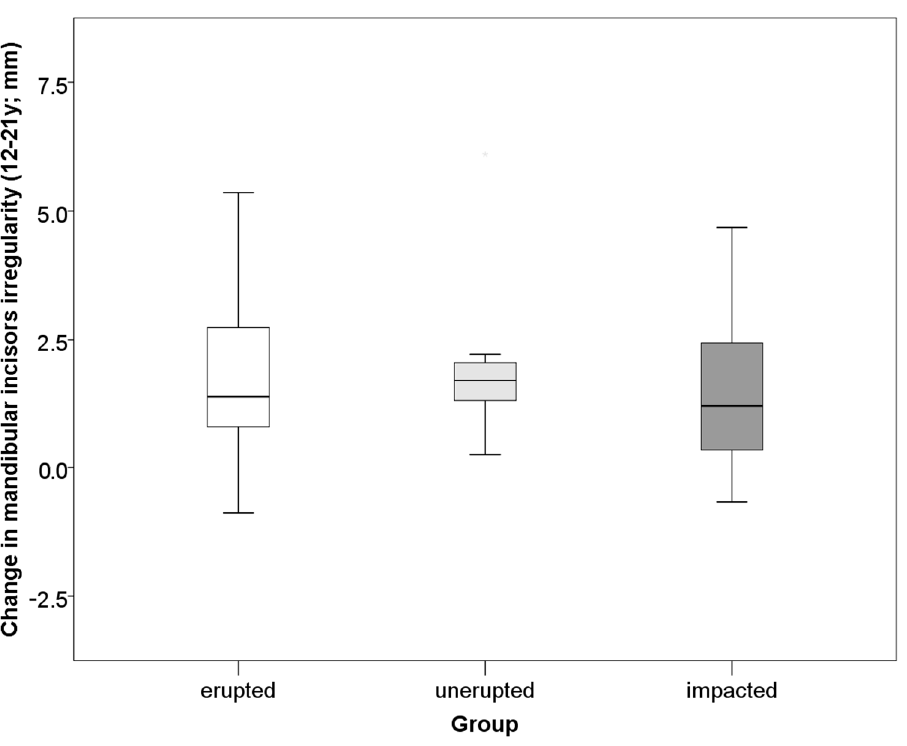
Figure 5. Comparison of change in mandibular incisor irregularity (The irregularity index) from 12 to 21 years between the groups with erupted, unerupted and impacted third molars.